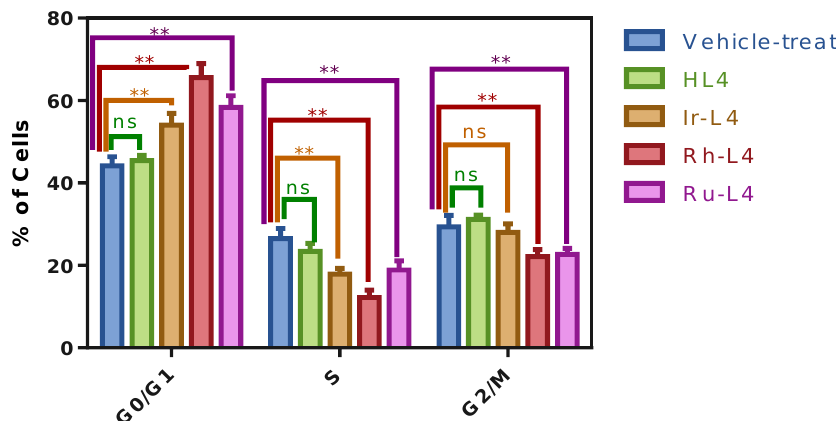
Figure 12. Flow cytometry analysis of cell cycle distribution of A549 cells treated during 24 h with the compounds under study. Data were obtained from duplicates of two different experiments and plot as mean values ± SD. ns No significance and ** Statistical significance, p -value < 0.01 (ANOVA-Dunnett).